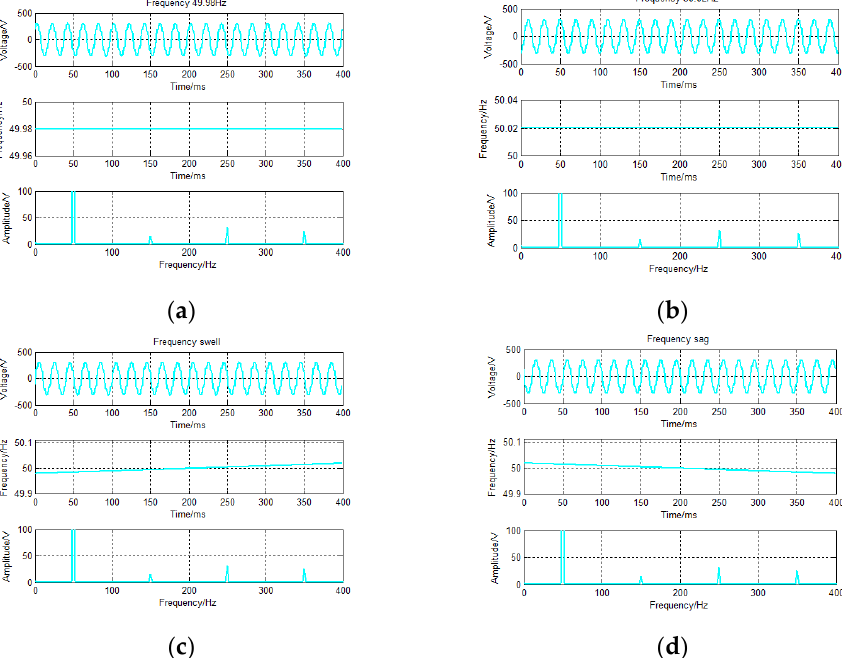
Figure 13. Experiment data for voltage frequency slight fluctuations. ( a ) Frequency 49.98 Hz; ( b ) Frequency 50.02 Hz; ( c ) Frequency swell; ( d ) Frequency sag.